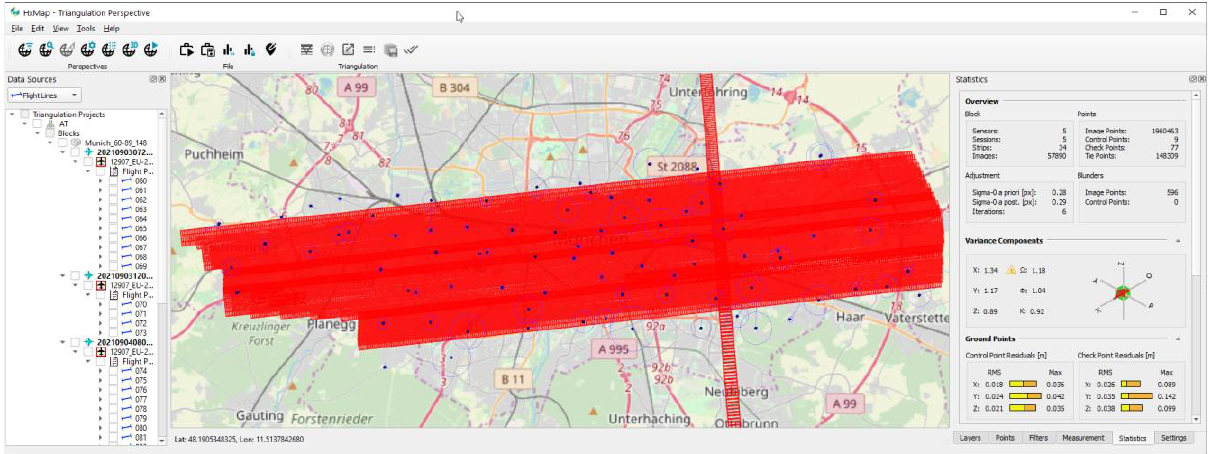
Figure 5. HxMap Workflow Manager with the AT project for the Munich Central block, showing some key statistics on the right.